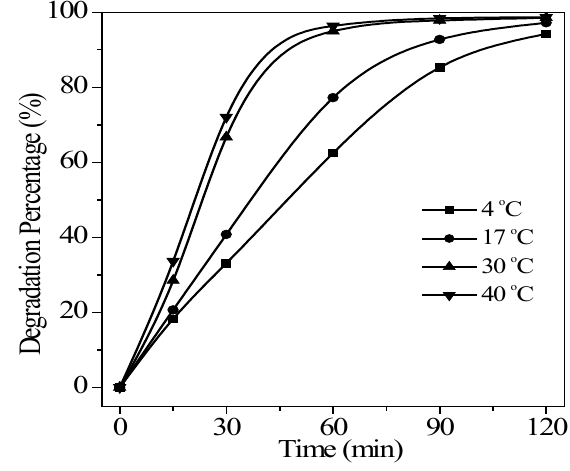
Figure 7. Effect of temperature on the photocatalytic degradation of quinoline. Conditions: flow rate = 0.35 L/min, pH = 6.7, C = 40 mg/L, and the maximum irradiation 0